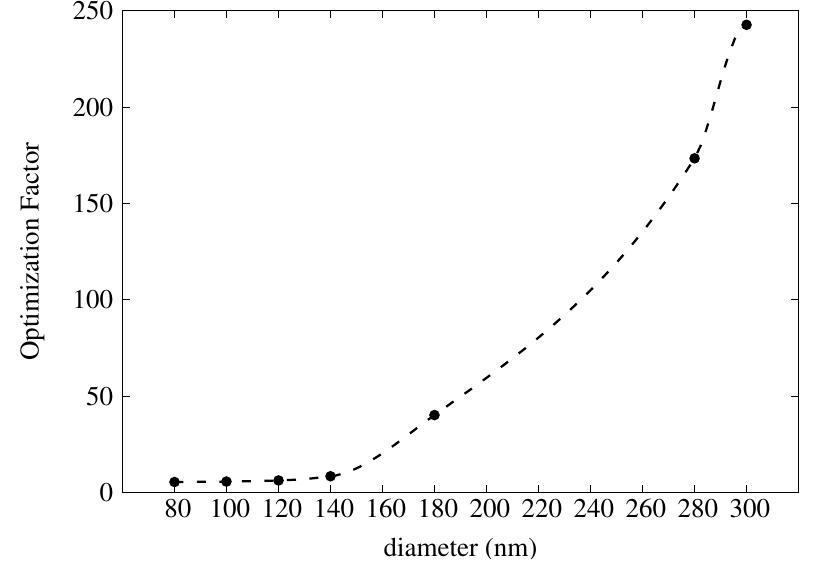
Figure 8. Plot of optimization factors as a function of particle diameter for spherical gold nanoparticles imbedded in an NW plasmonic crystal. Dashed lines correspond to spline interpolation between data points and are meant for ease of visualization